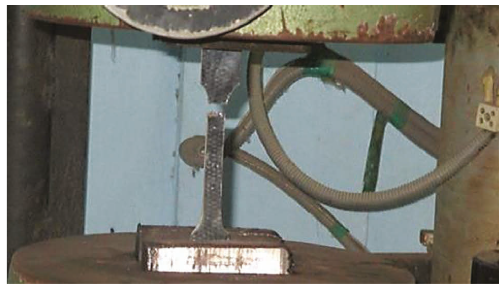
Figure 3: UTM tensile testing of the sample specimen.